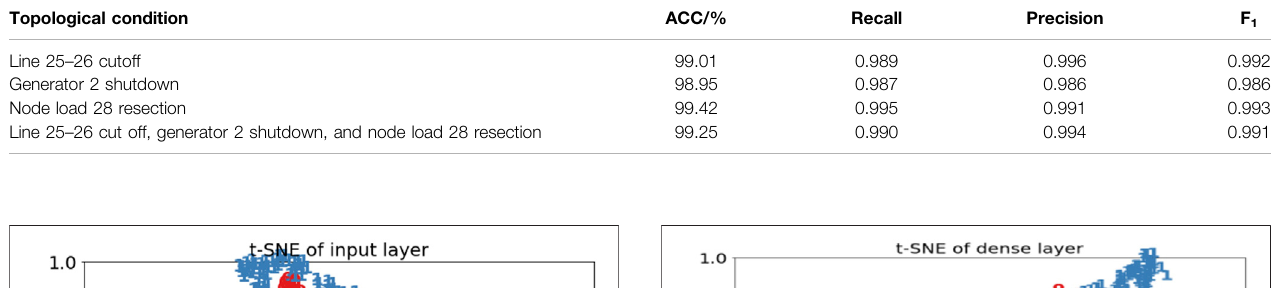
TABLE 4 | Results of TSA under topological structure change. Topological condition